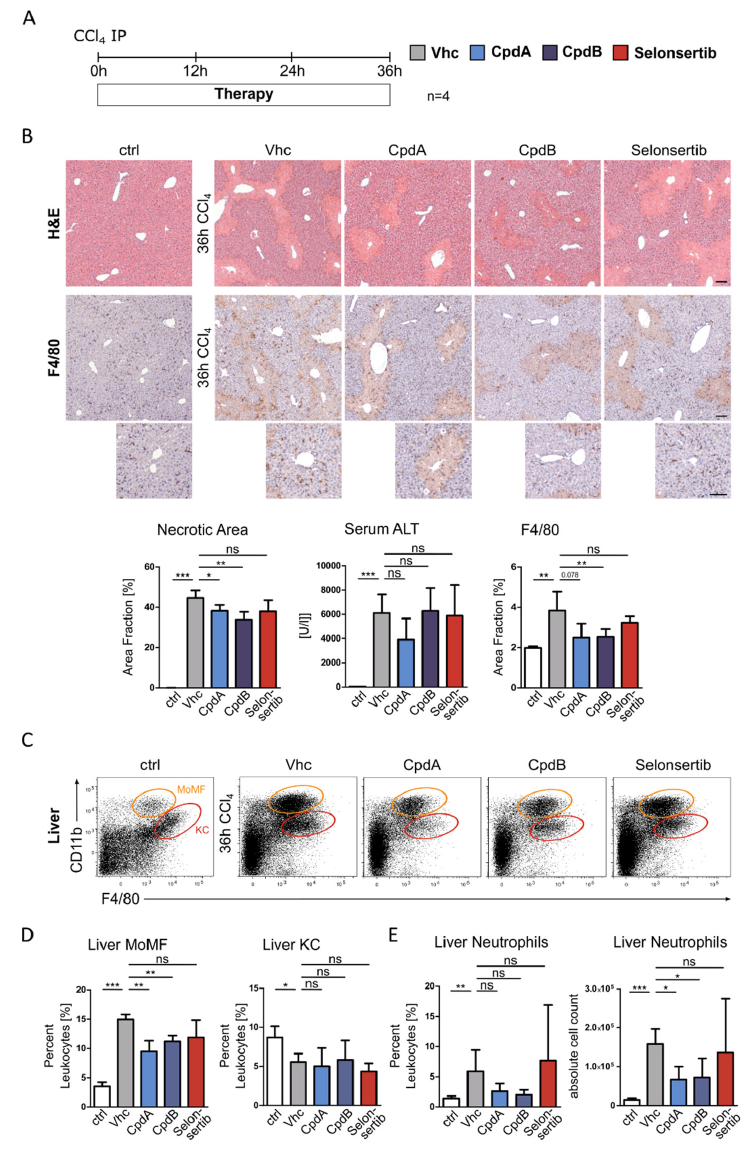
Figure 2. Pharmacological inhibition of GPR84 decreases infiltration of neutrophils and macrophages in CCl 4 -induced acute liver injury. ( A ) In vivo effects of GPR84 inhibition on leukocyte infiltration were assessed in c57bl / 6 wildtype mice ( n = 4), 36 h after being challenged with a single intraperitoneal (IP) injection of carbon tetrachloride (CCl 4 ). Mice were treated by oral gavage with different GPR84 antagonists (30 mg/kg BW, at 0 h, and 24 h) or selonsertib (15 mg/kg BW, at 0 h, 12 h, and 24 h). ( B ) Liver histology (H&E staining), immunohistochemistry for the macrophage marker F4/80 (overview and higher magnification of periportal areas below) and serum alanine transaminase (ALT) levels. ( C–E ) Immune cell infiltration was characterized from mouse livers by FACS (representative FACS plots shown in C), revealing reduced numbers of hepatic neutrophils (E, relative and absolute counts are shown), as well as monocyte derived macrophages (MoMF), after a CCl 4 injection, in case of GPR84 inhibition, while the Kupffer cells (KC) remained unchanged ( D ). All images were taken at × 10 objective magnification; scale bar, 100 µ m. Data are presented as mean ± SD, based on n = 4 per group. * p < 0.05, ** p < 0.01, *** p < 0.001 (one-way ANOVA). Abbreviations are: CpdA / B, compound A / B; KC, Kup ff er cells; MoMF, monocyte-derived macrophages; and Vhc,